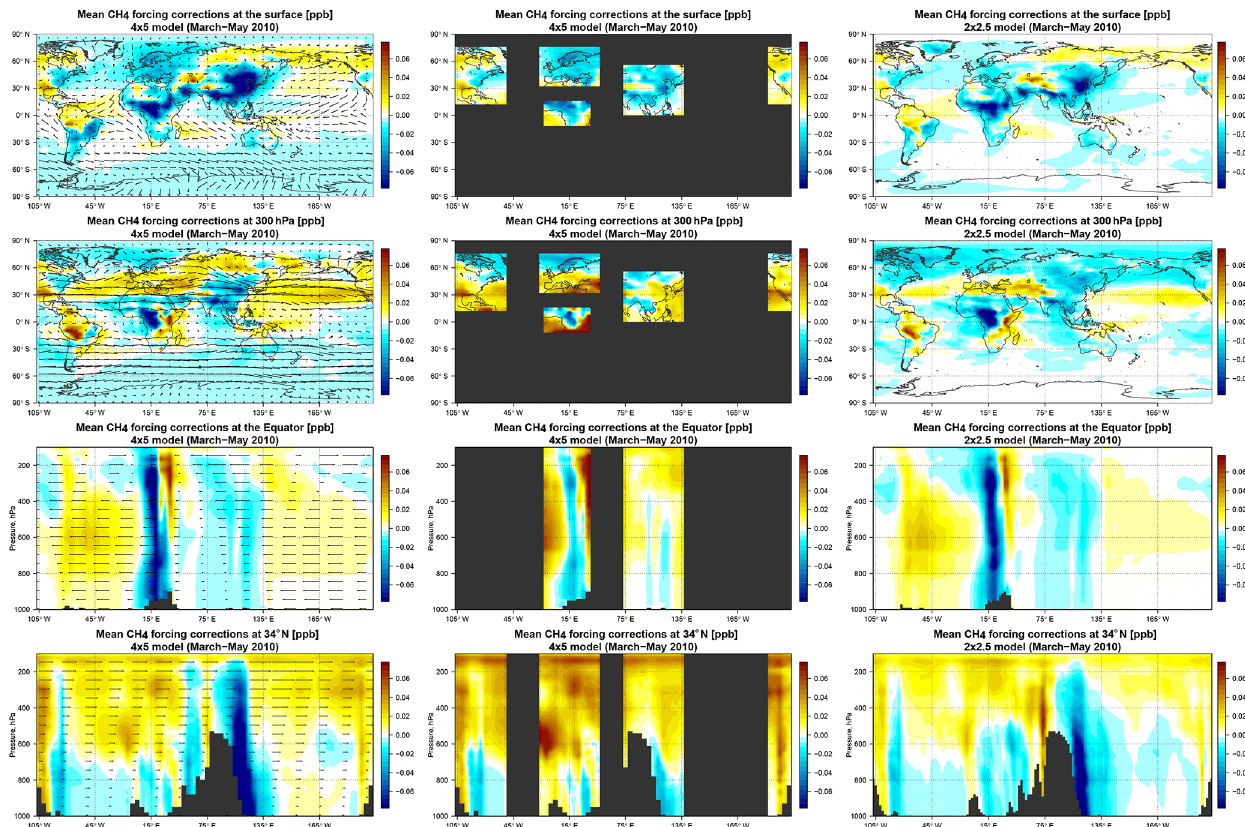
Figure 13. Mean optimized forcing terms (in ppb) for March–May 2010. Left column: WC_4x5 assimilation at 4 ◦ × 5 ◦ . Middle column: WC_4REG_4x5 assimilation at 4 ◦ × 5 ◦ . Right column: WC_2x25 inversion at 2 ◦ × 2.5 ◦ . Top row: forcing terms at the surface. Second row: forcing terms at 300hPa. Third row: altitude–longitude distribution of the forcing terms along the Equator. Bottom row: altitude–longitude distribution of the forcing terms along 34 ◦ N. In the plots in the left column, arrows represent the direction and relative magnitude of horizontal